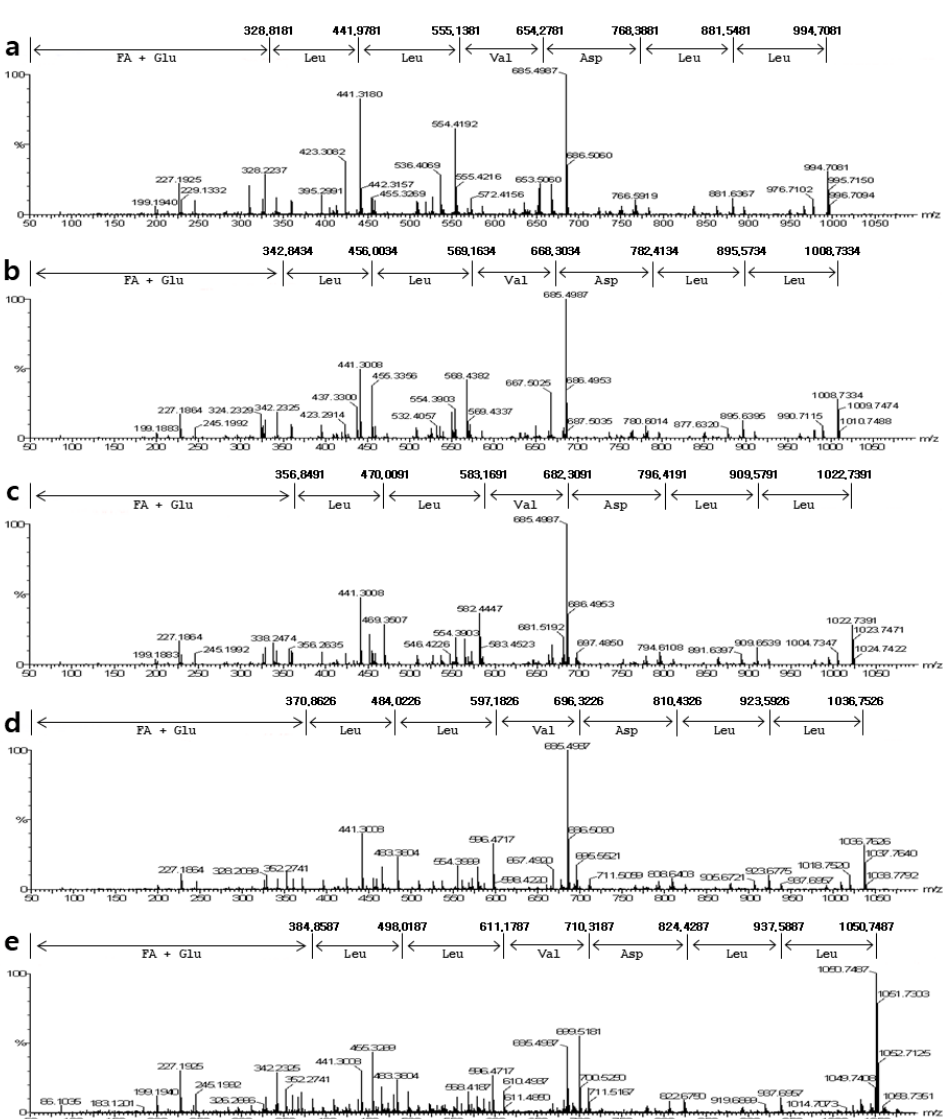
Figure 4. ESI tandem mass spectrometry fragmentation of surfactin isomers: Peptide sequences of five surfactin isomers were identified based on the MS/MS spectrum of the precursor ion m/z 994.7081, 1008.7334, 1022.7391, 1036.7528, and 1050.7487. ( a ) 994.7081 m/z ; ( b ) 1008.7334 m/z ; ( c ) 1022.7391 m/z ; ( d ) 1036.7528 m/z ; and ( e ) 1050.7487 m/z .